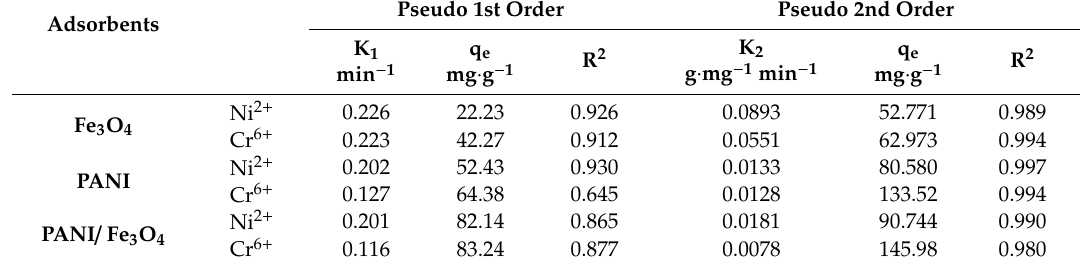
Table 2. Parameters of kinetics study of Cr(VI) and Ni(II) adsorption. Adsorbents